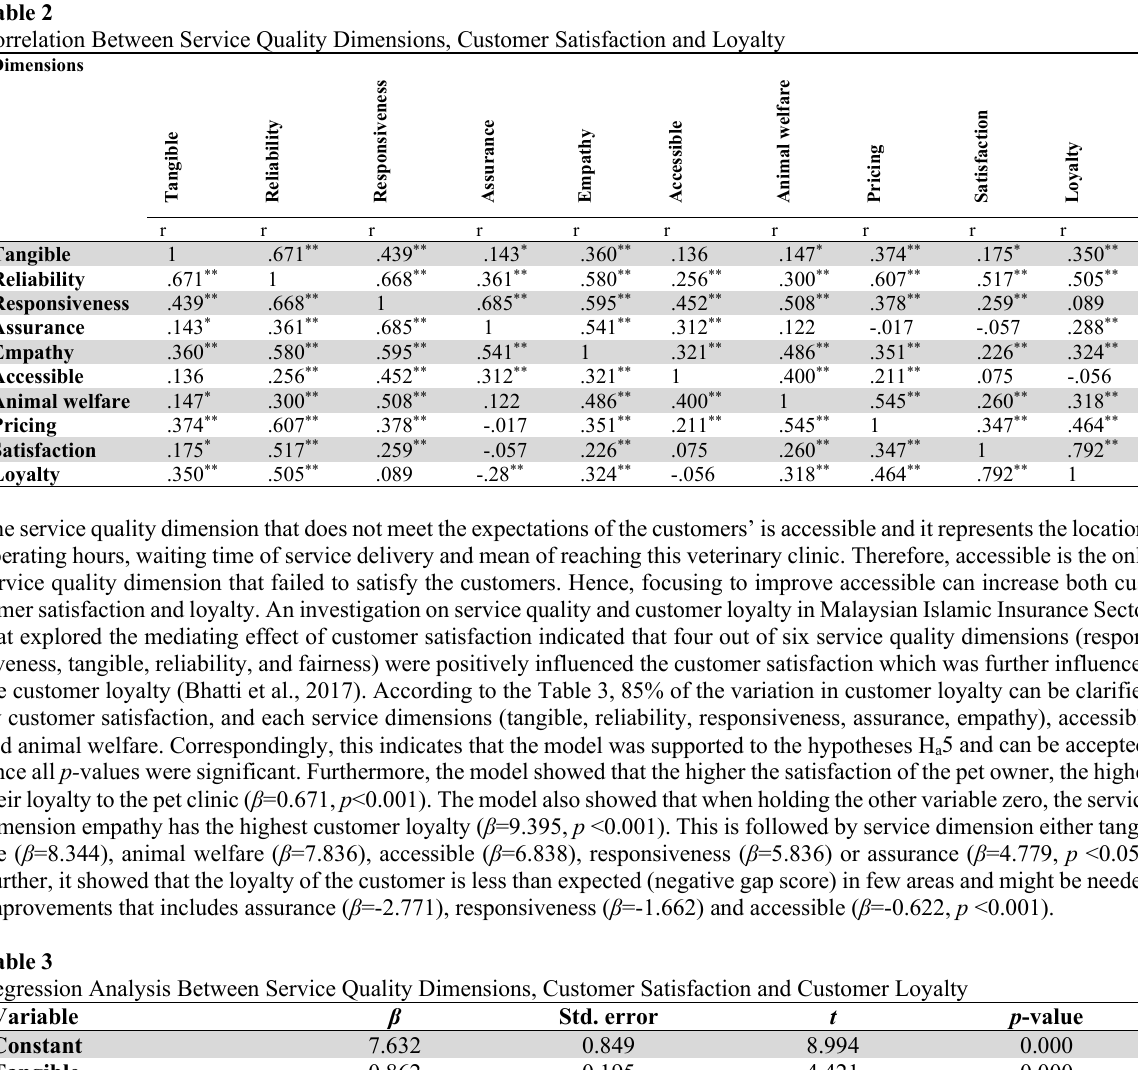
Correlation Between Service Quality Dimensions, Customer Satisfaction and Loyalty Dimensions